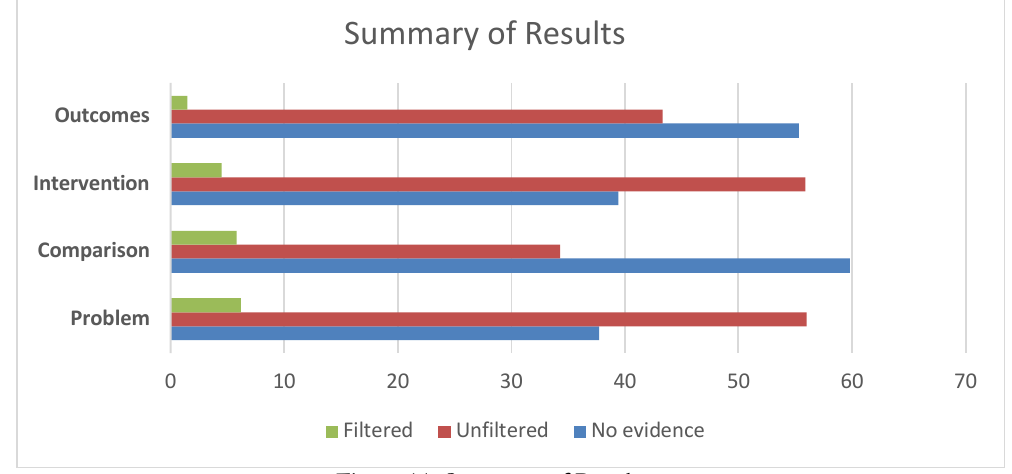
Figure 11: Summary of